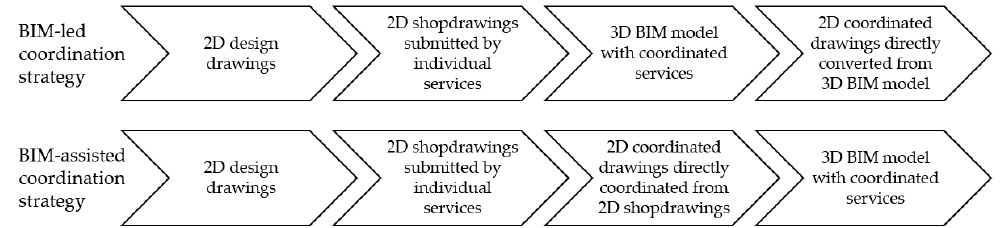
Figure 4. A comparison between BIM-led and BIM-assisted coordination strategies, which use a mixture of 2D drawings and a 3D BIM model modified from [30].